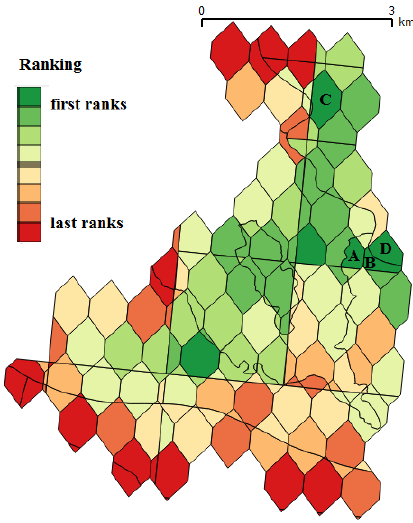
Figure 14. Areas ranked considering energy, cost and